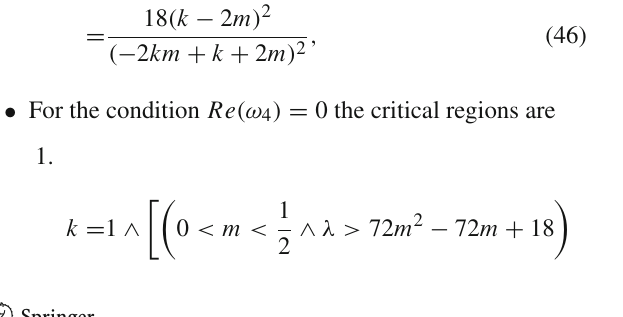
direction of the velocity field and the trajectories reveal their stability properties as described for this model